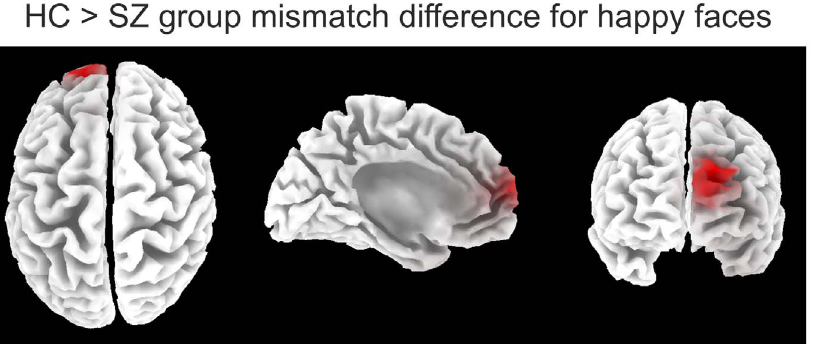
Figure 5. Results of the source localization for the happy condition. Red color indicates significant group differences in mismatch generation to the happy condition in the 250–360 ms time window. (HC=Healthy Controls, SZ=Patients with Schizophrenia).